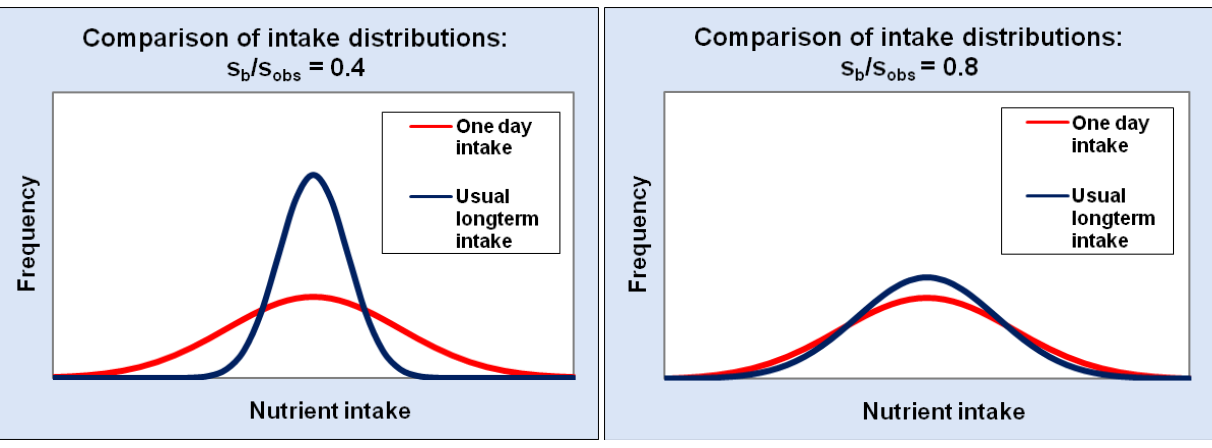
/s ) in reducing b obs